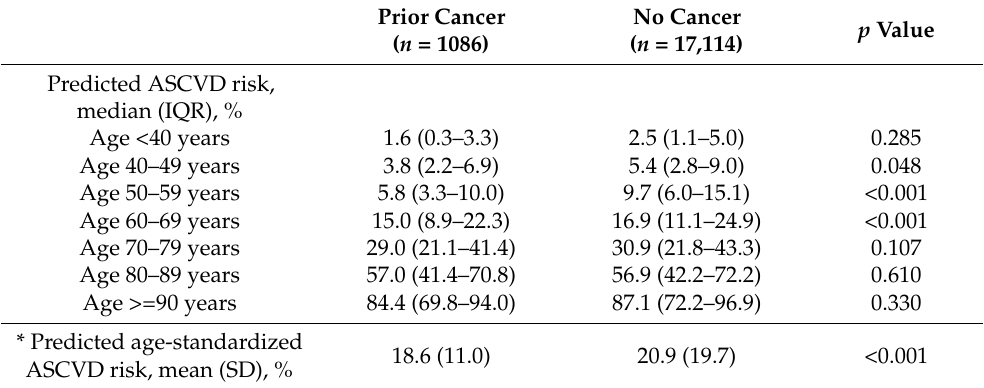
Table 2. ASCVD risk by cancer status.